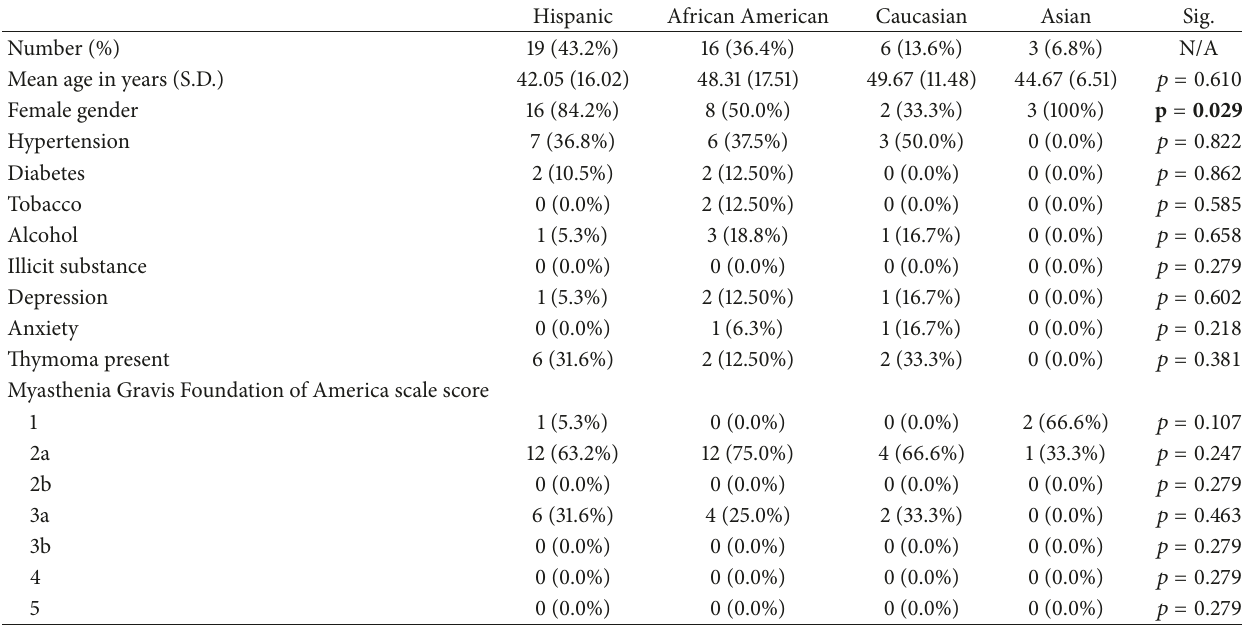
Table 1: Ethnicity and clinical features in myasthenia gravis.